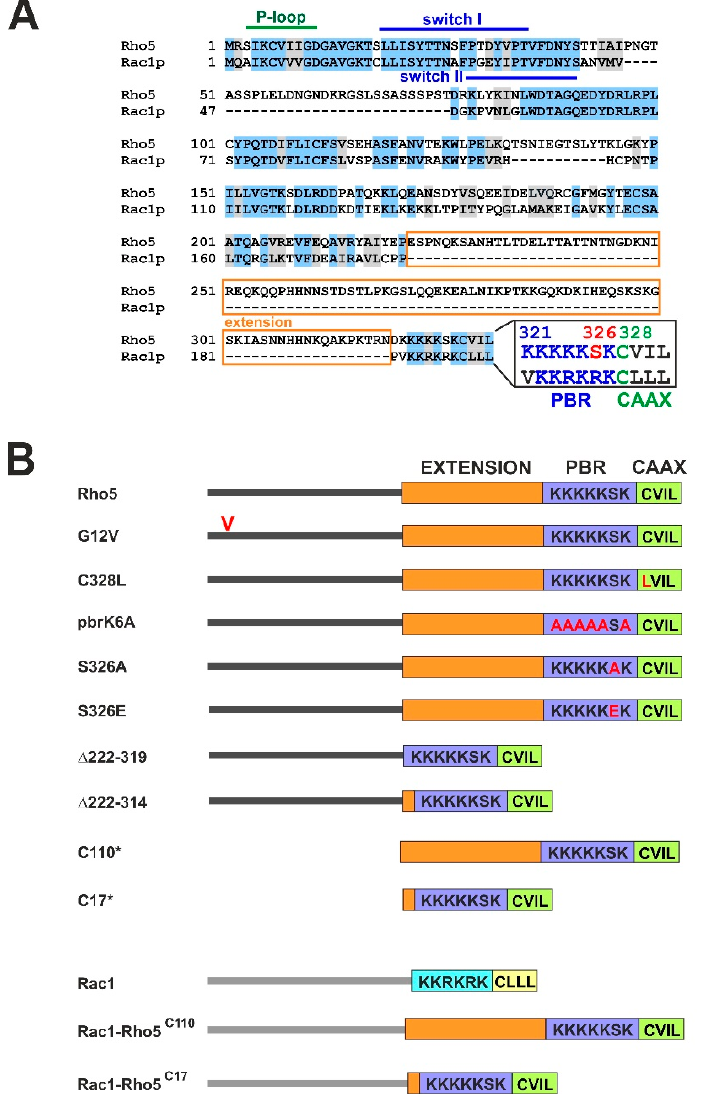
Figure 1. Comparison of yeast Rho5 with its human Rac1 homolog and mutants constructed. ( A ) Alignment of the primary sequences of Rho5 and Rac1. Identical amino acid residues are shaded in blue, conserved ones in grey. Domains relevant for the activation of the GTPases (P-loop, switch I and II regions), as well as the conserved sequences at the C-terminal end (PBR = polybasic region; CAAX = site of lipid modification, with a cysteine, two aliphatic and one variable terminal residues) are highlighted. The orange box designates a 98 amino acid extension specific for Rho5 of Saccharomyces cerevisiae . Accession numbers for the coding sequences are KZV08440 for S. cerevisiae Rho5, and CAB53579 for human Rac1. ( B ) Schematic representation of mutants used in this study. Designations of Rho5 and Rac1 variants used in the text are depicted at the left. Exchanges of amino acid residues are shown in red letters, including the valine near the N-terminus in the G12V mutant. Dark and light grey lines represent the catalytic domains of Rho5 and Rac1, respectively. Rectangles in orange designate the yeast-specific sequences of the 98 aa extension. The polybasic regions are highlighted in dark blue for Rho5 and light blue for Rac1, the CAAX motif in green for Rho5 and yellow for Rac1. For localization studies, all constructs were N-terminally tagged with GFP and expressed from CEN/ARS vectors. * C110 and C17 were exclusively used as N-terminal GFP fusions and not as untagged versions at the genomic locus .